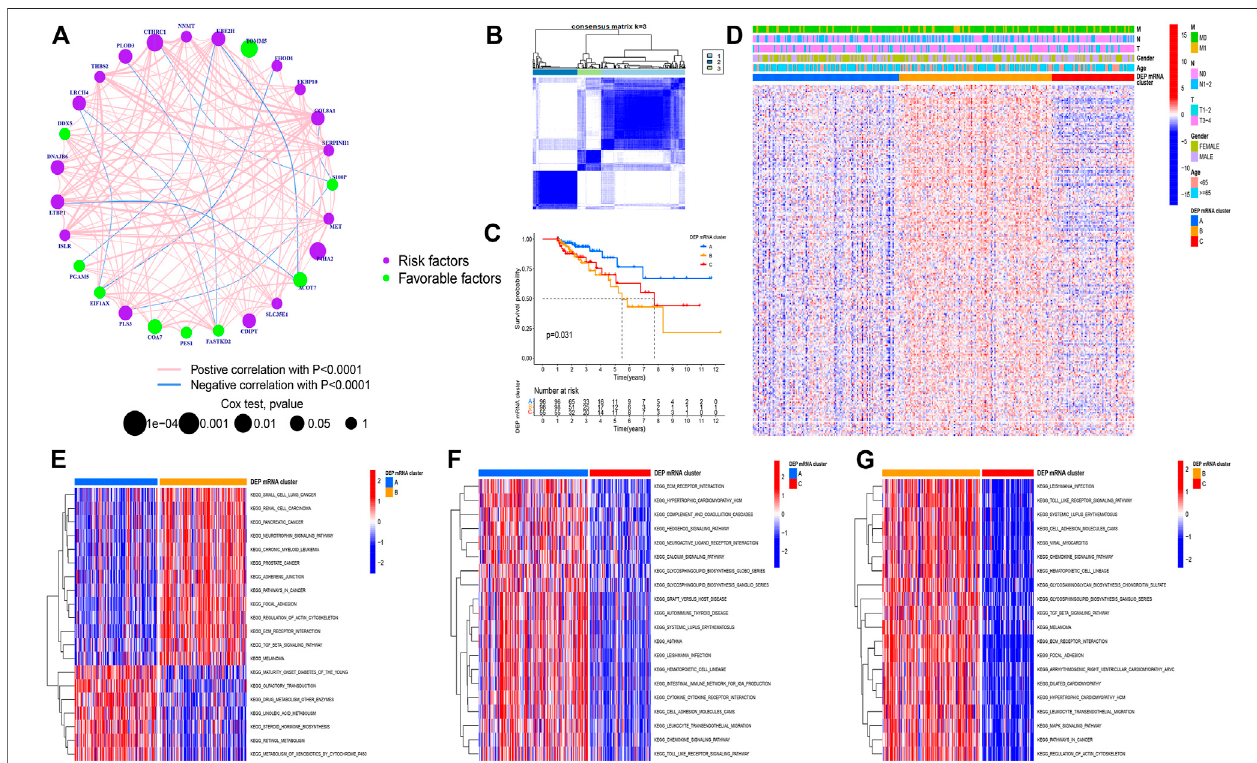
FIGURE 2 | (A) Correlation among DEP mRNA in CC. The circle size represents the effect of each regulator on the prognosis. The range of values calculated by Log-rank test was p < 0.001, p < 0.01, p < 0.05, and p < 0.1, respectively. The green dots in the circle represent favorable prognostic factors; Purple dots in the circle representprognosticriskfactors. The lineslinkingregulatorsindicateinteractions,and their thickness showscorrelationstrength betweengenes.Negative correlation is markedinblueandpositivecorrelationinred. (B) ConsensusmatrixesofallCCsamplesforappropriatekvalue(k=3),displayingtheclusteringstabilityusing1,000 iterations of hierarchical clustering. All samples were clustered into three subtypes. (C) Survival analyses for the three DEP mRNA cluster based on 1,051 patients with CC from GEO cohorts including 96 cases in cluster-A, 98 cases in cluster-B, and 55 cases in cluster-C. Kaplan-Meier curves with Log-rank p -value = 0.031 showing signi fi cant survival difference among the three DEP mRNA patterns. The DEP mRNA cluster A had signi fi cantly better overall survival than the other two clusters. (D) A heat map showing the unsupervised clustering of DEP mRNA in all CC samples. Columns represent samples. A heatmap visualizing the clinical parameters. Red represents activation and blue represents inhibition. CC cohorts were used as sample annotations. (E – G) Results of GSVA enrichment analysis showing different tumor typesinthethreeDEPmRNApatterns.Redrepresentsactivationandbluerepresentsinhibition. (E) DEPmRNAclusterAvsDEPmRNAclusterB; (F) DEPmRNAcluster A vs DEP mRNA cluster C; (G) DEP mRNA cluster B vs DEP mRNA cluster